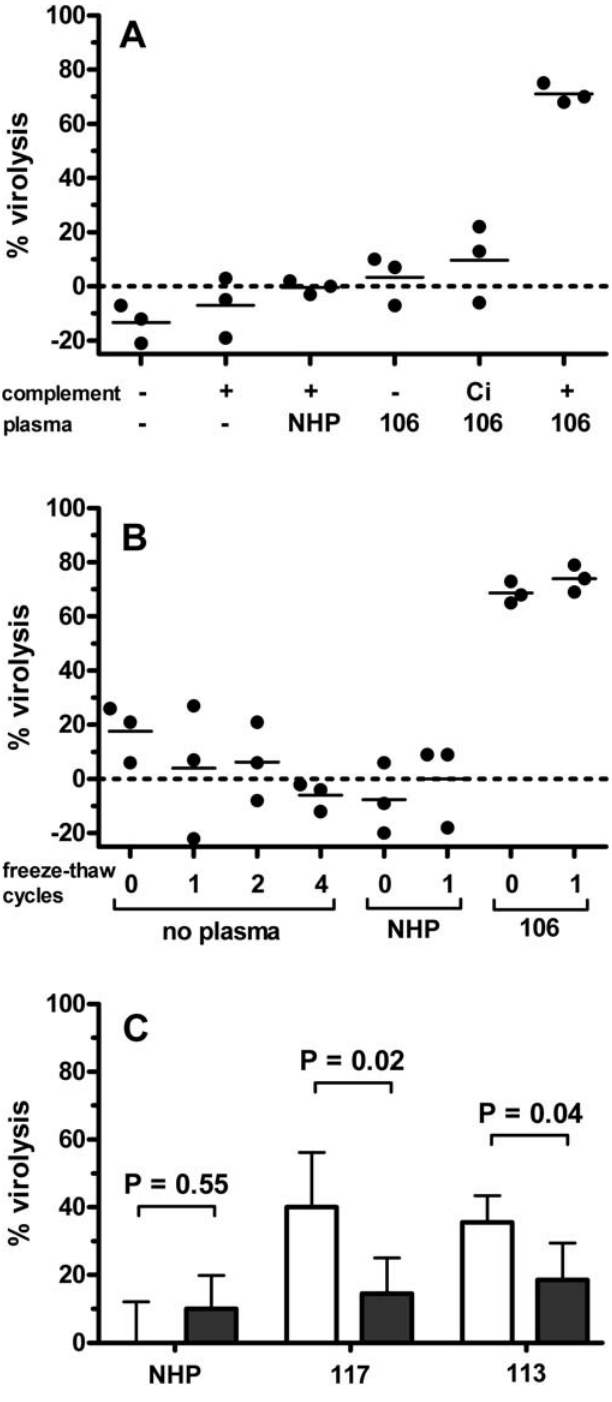
Figure 2. Virolysis by Antibody and Complement (A) Plasma from HIV-positive individuals specifically lyses HIV in presence of active complement. Virus isolate JR-FL was incubated with comple- ment ( þ ), without complement ( (cid:1) ), or with inactivated complement (Ci) either in the absence of plasma ( (cid:1) ) or with plasma from uninfected individuals (NHP) or from patient 106. One of three independent experiments is shown. (B) Up to four freeze-thaw cycles do not destroy intact HIV-1 virions. Virus JR-FL was incubated in the presence of active complement with medium (no plasma), with plasma from uninfected persons (NHP), or with plasma from patient 106. Reaction mixtures were subjected to the